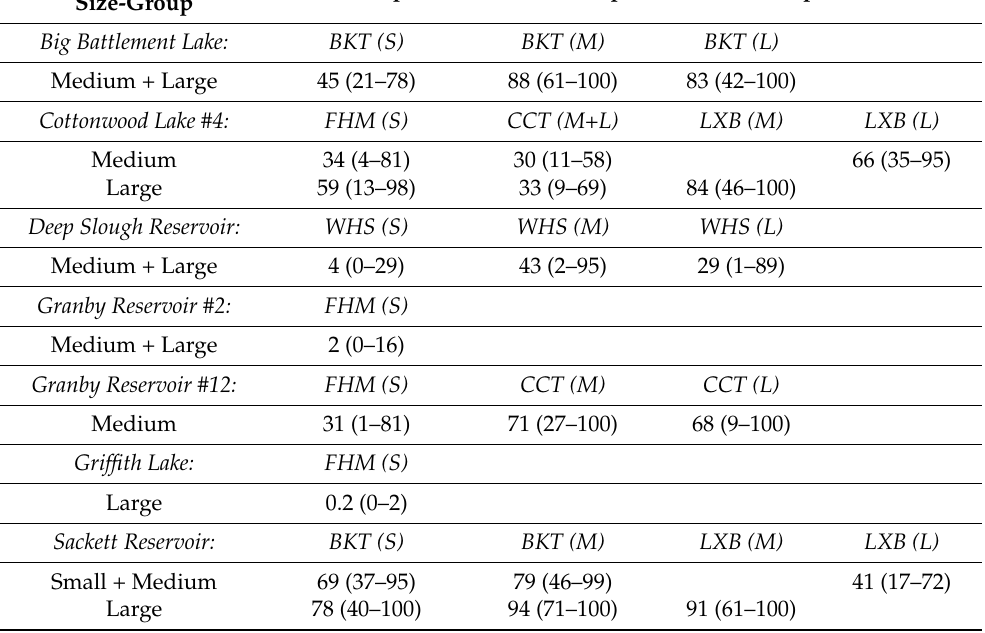
Table 4. Bayesian estimates of mean percent overlap in trophic niche space between different size-groups of tiger trout and between tiger trout and other species of undesirable fish. Values in parentheses represent 95% credible intervals. For the matrix, values represent the probability (expressed as a %) of an individual tiger trout of a given size listed in each row falling within the trophic niche space of each fish species and size-group listed in column headings (italicized) adjacent to each study system name. Reciprocal probabilities are not shown. The acronyms BKT, FHM, WHS, and LXB stand for brook trout, fathead minnow, white sucker, and tiger trout, respectively. The letter “L” stands for large fish ( ≥ 250 mm TL), “M” for medium fish (150 − 249 mm TL), and “S” for small fish (<150 mm TL). In some cases, size-groups were combined for analysis to meet minimum sample size